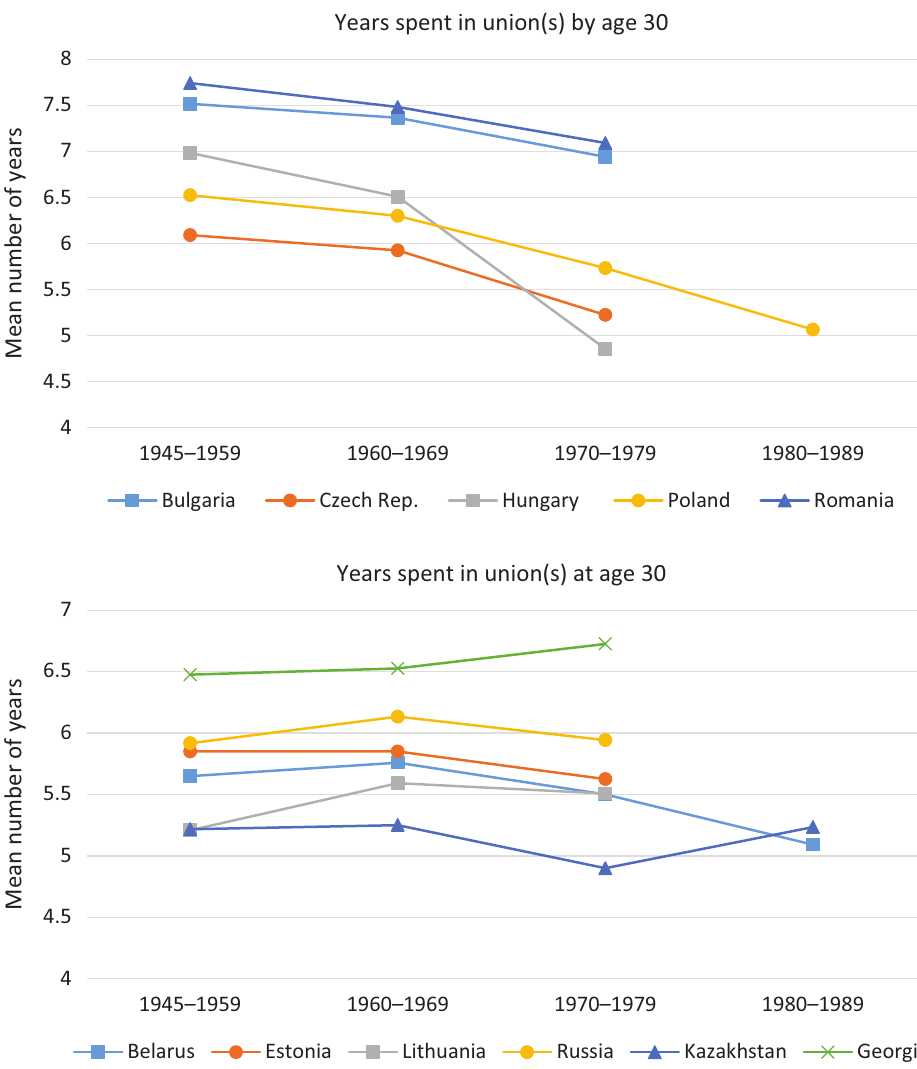
Figure 4. Average number of years women spent in co‐residential unions by country and birth